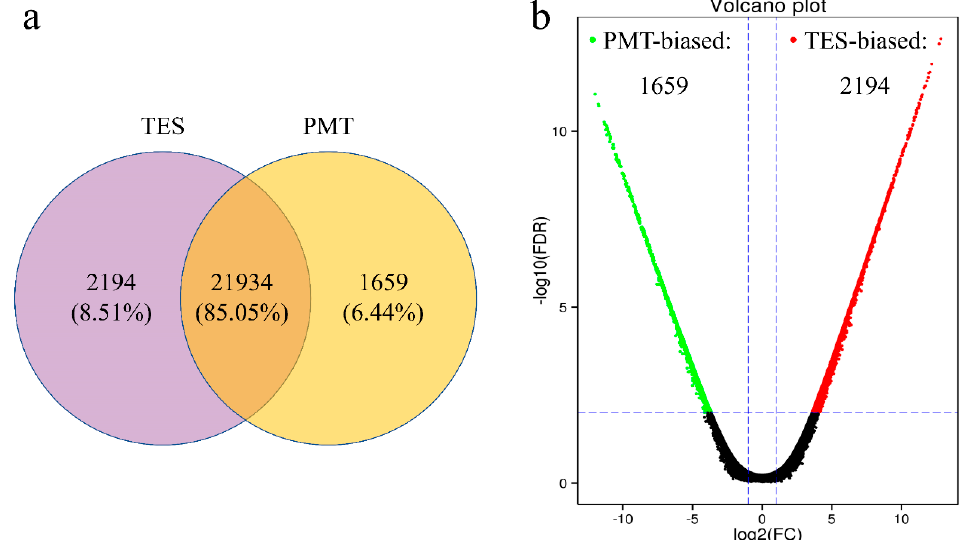
Figure 6. Comparative results of RNA-Seq and differentially expressed gene distributions between the TES and PMT. ( a ) Venn diagram showing genes expressed highly in the TES (light purple circle), expressed highly in the PMT (light yellow circle), and expressed without significant difference in both samples (intersection). ( b ) Volcano scatter plot of differentially expressed genes (TES vs. PMT). Red points represent the testes-biased genes with log 2 (fold change) > 2 and Q value < 0.01, i.e., − log 10 ( Q value) ≥ 2.0. Green points represent somatic-biased genes with log 2 (fold change) < − 2 and Q value < 0.01, i.e., − log 10 ( Q value) ≥ 2. Black points represent genes with no significant differences. Fold change equal to normalized gene expression of the TES/normalized gene expression of the PMT.